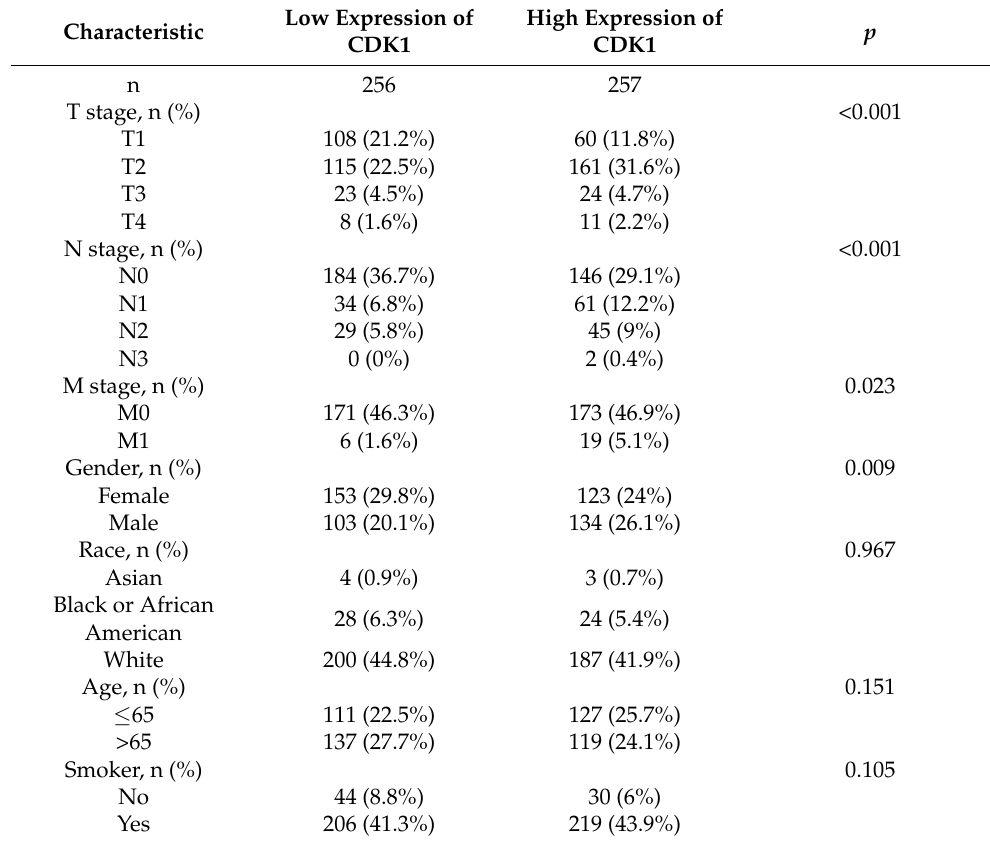
Table 1. The general information of patients with different CDK1 expression levels. The data for analysis were from the LUAD project in TCGA